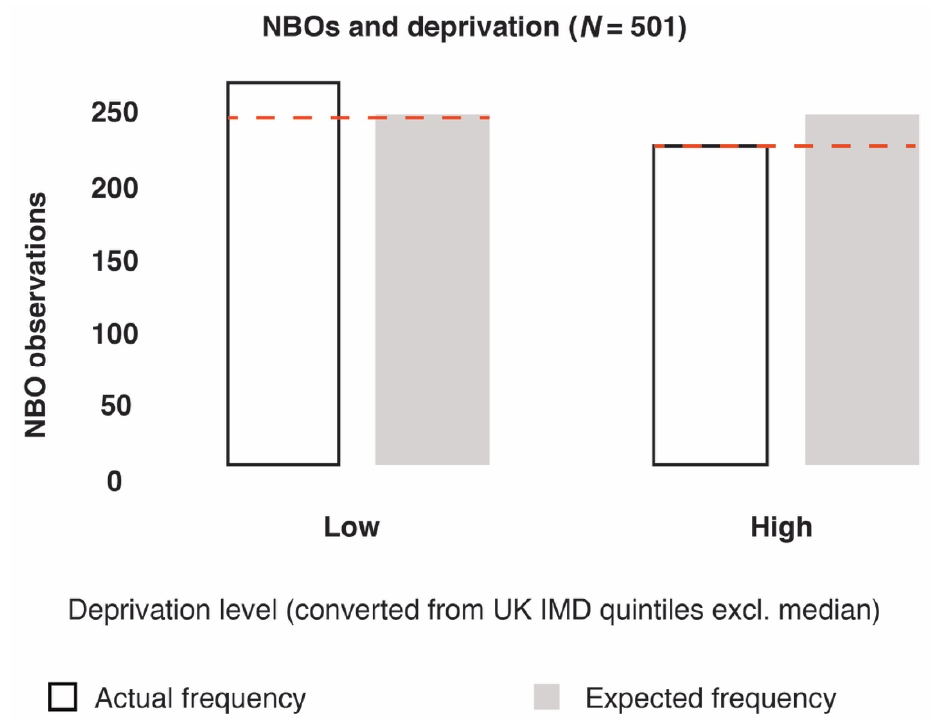
Figure 13. Output of X 2 results: the frequencies of NBOs were significantly different between areas with low and high levels of deprivation (based on converting UK IMD quintile scores into low- and high-deprivation categories).